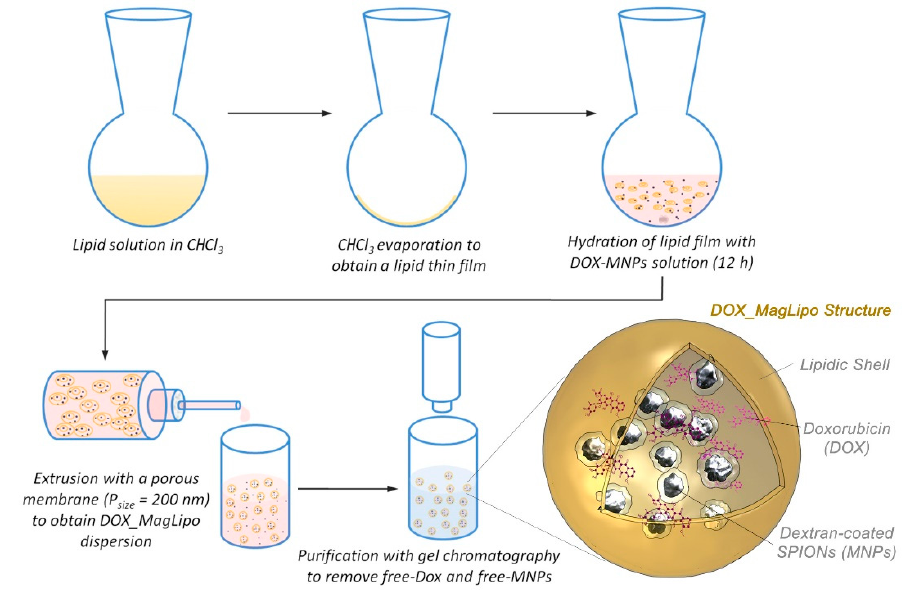
Figure 1. DOX_MagLipo fabrication and purification process and schematic structure. For MagLipo fabrication a 2 mg / mL MNPs solution without DOX was used.